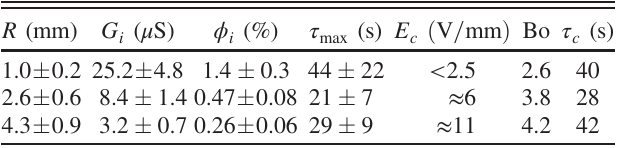
TABLE I. Values of the different averaged quantities in our experiments, calculated or experimentally measured. Radius R is in mm, the initial conductance G in μ S, the initial liquid fraction i ϕ in %, times τ and τ are in seconds (s), the critical electric i c max field E in V/mm, and Bo is the Bond number [Eq. c